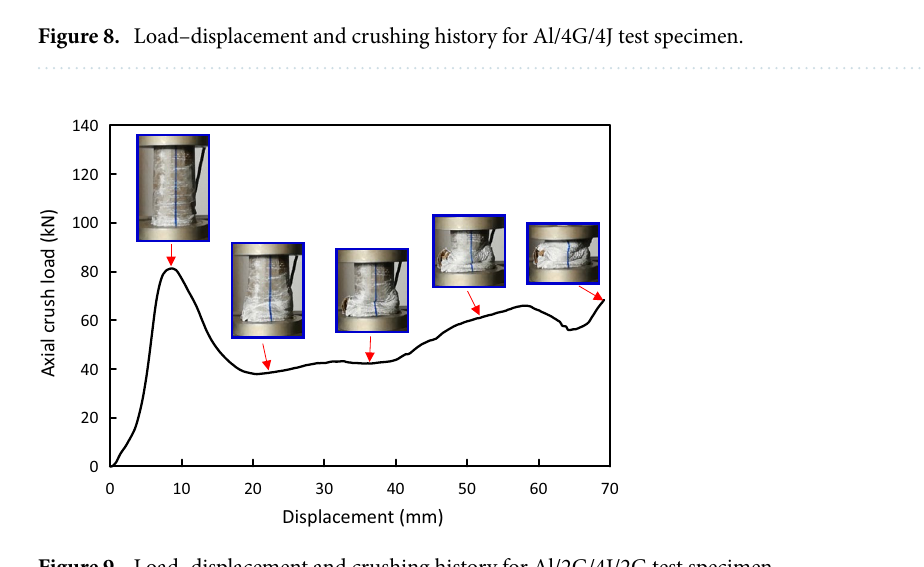
Figure 9. Load–displacement and crushing history for Al/2G/4J/2G test specimen.